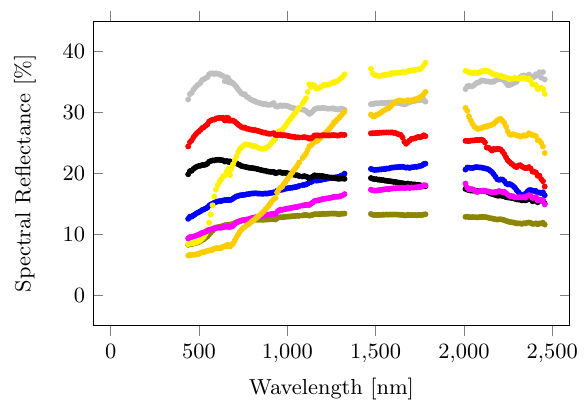
Figure 3. Mean spectra for the URBAN-SAT dataset ( Glass : cyan; Concrete : red; Metal : gray; Wood : orange; Fibre Cement : green).